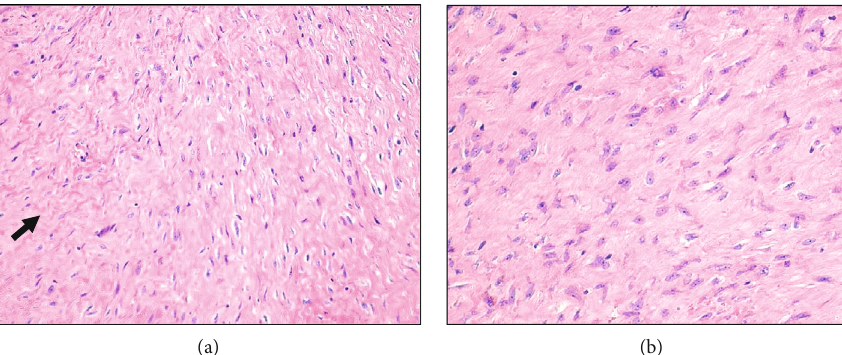
Figure 3: (a and b) Microscopically, the lesion consisted of a proliferation of relatively uniform spindle cells, arranged in long fascicles, with fusiform nuclei and inconspicuous nucleoli, in an abundant collagenous stroma, pointed by the black arrows. The tumor showed an in fi ltrative pattern of growth.